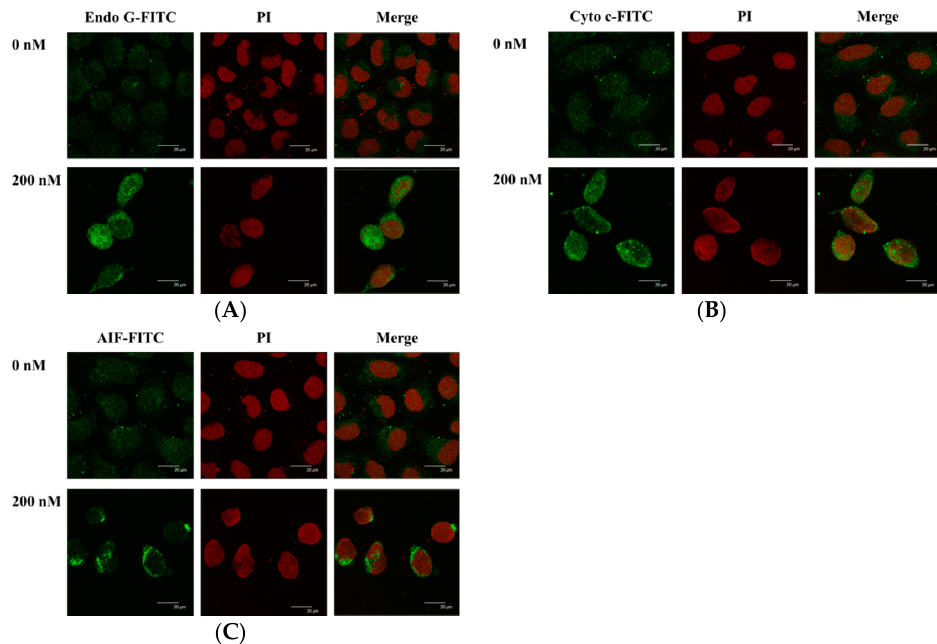
Figure 7. Bufalin affects the translocation of apoptotic-associated proteins in U-2 OS cells. Cells were treated with 200 nM of bufalin for 48 h, and cells were stained by ( A ) anti-Endo G, ( B ) -cytochrome c, and ( C ) -AIF and then were stained with a secondary antibody and were examined and photographed by a Leica TCS SP2 confocal laser microscopic system, as described in Materials and Methods.